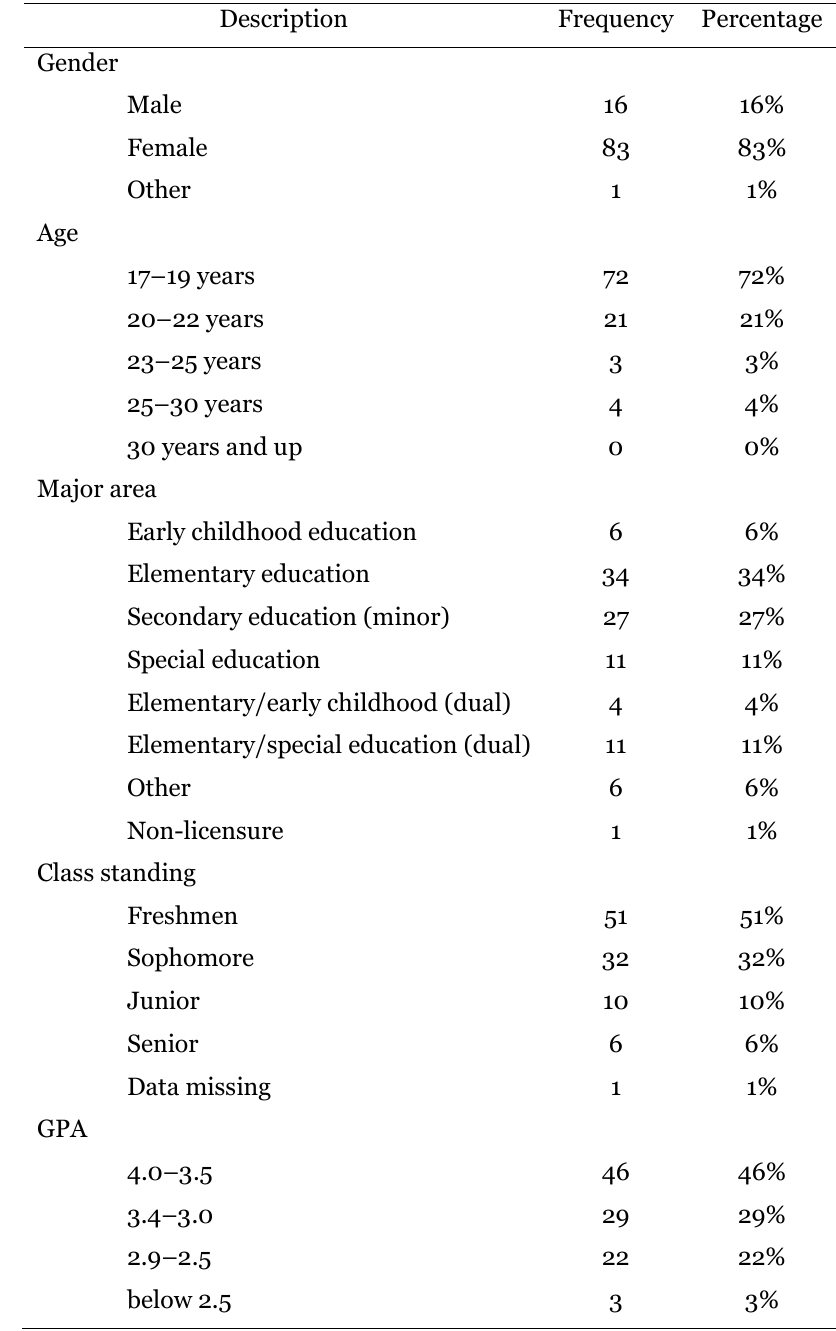
Table 2 Participant Demographics (N = 100)